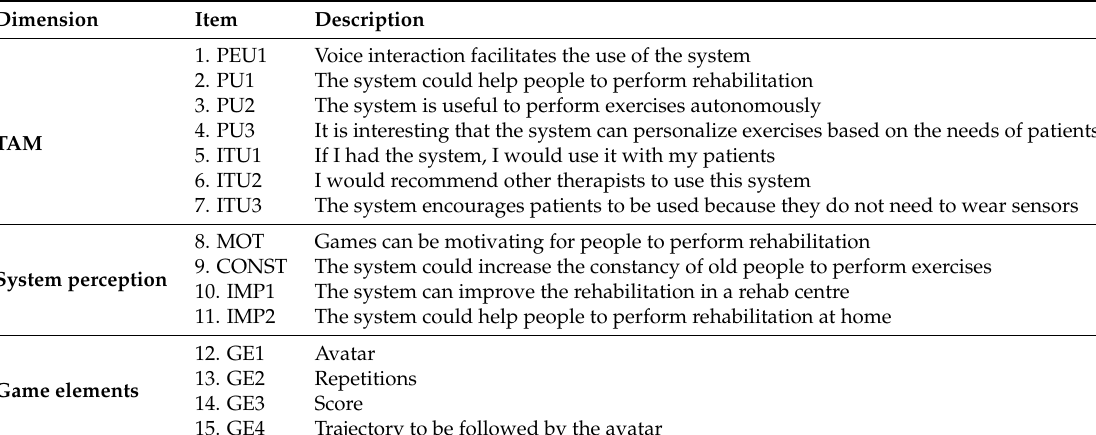
Table A2. Textual description of the items evaluated by